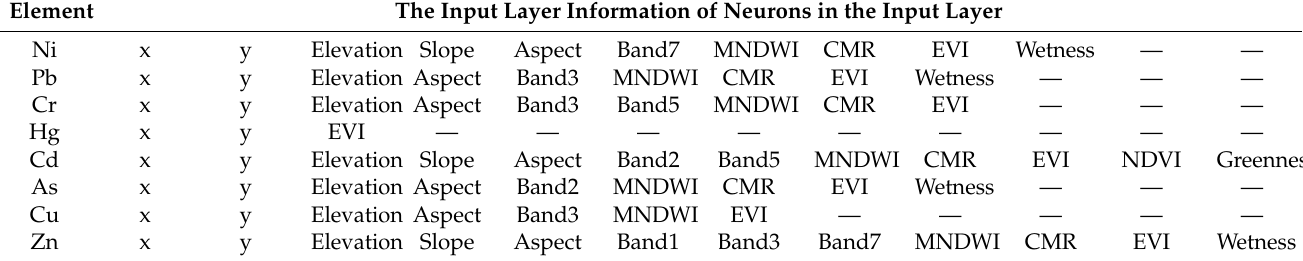
Table 2. The input layer information.